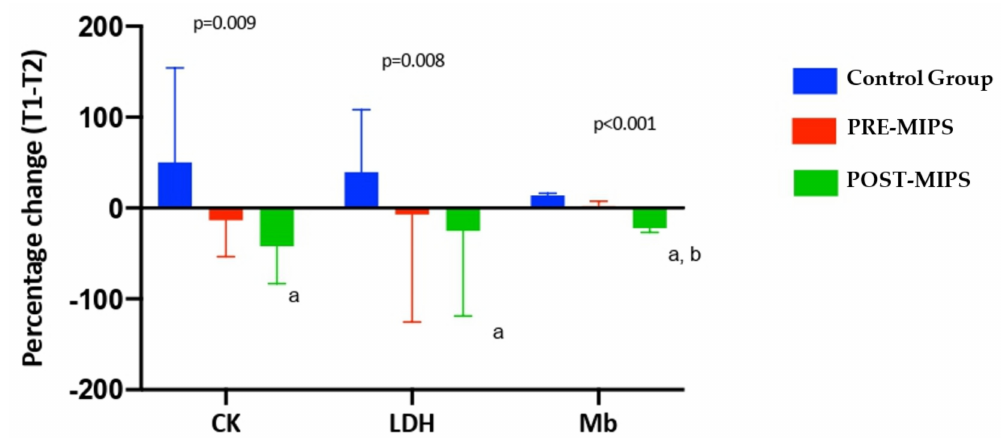
Figure 1. Percentage change in muscle damage parameters between T1-T2. The data are expressed as a mean ± standard deviation. ∆ (T1-T2) (%) = ((T2T1)/T1) × 100.CK: Creatine kinase; LDH: Lactate dehydrogenase; Mb: Myoglobin. T1: Before the start of the race; T2: After 10 weeks of treatment. p : Group differences obtained through 1-factor ANOVA. a : Significant differences from the Control group ( p < 0.05). b : Significant differences from the PRE-MIPS group ( p <